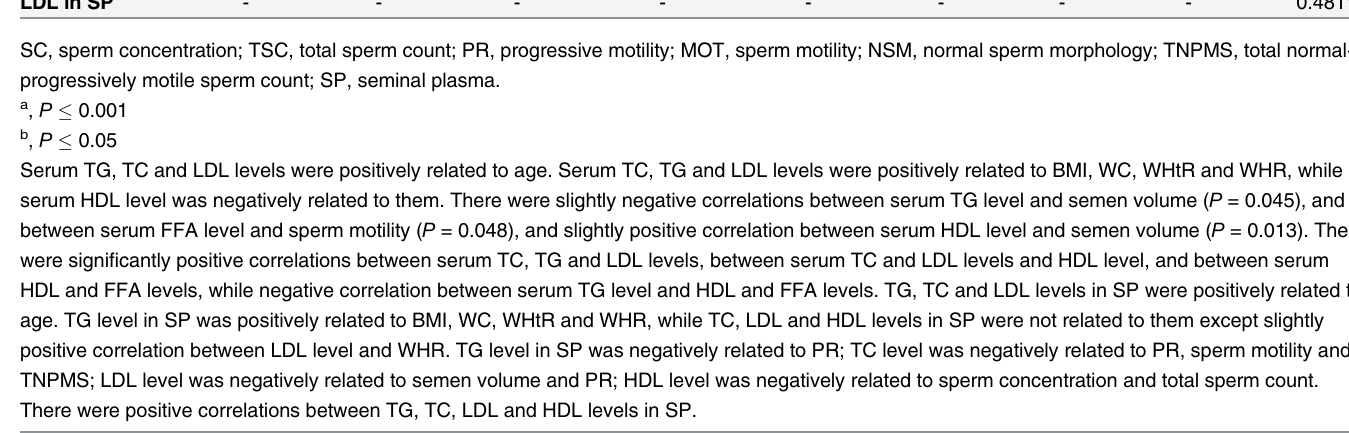
SC, sperm concentration; TSC, total sperm count; PR, progressive motility; MOT, sperm motility; NSM, normal sperm morphology; TNPMS, total normal- progressively motile sperm count; SP, seminal plasma. a